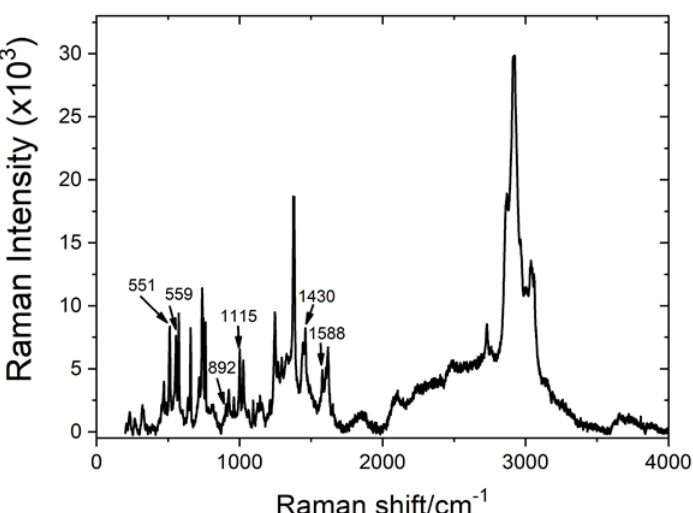
Figure 6. The Raman peak of technical deltamethrin pesticides from an Indonesian local brand .